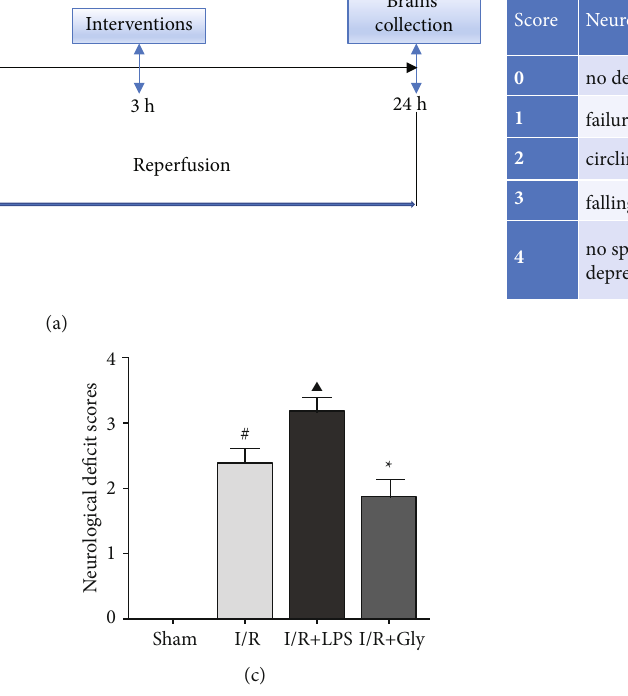
Figure 1: (a) Schematic diagram of the experimental protocol. (b) Longa ’ s score and corresponding neurobehavioral manifestation. (c) Neurological de fi cit scores of each group according to Longa ’ s score method, n = 10 . Data are presented as mean ± SD . # P < 0 : 05 , I/R group versus sham group; ▲ P < 0 : 05 , I/R +LPS group versus I/R group; ∗ P < 0 : 05 , I/R +Gly group versus I/R group.